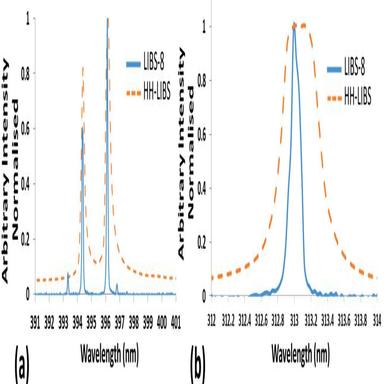
Emission line example of (a) aluminium (b) beryllium measured by the applied photonics LIBS 8 and the Hitachi High-tech LIBS instrument.